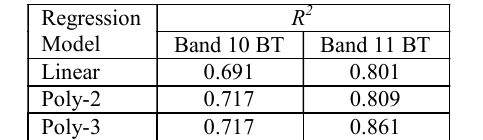
Table 5. Regression Model of Band 10 or Band 11 BT